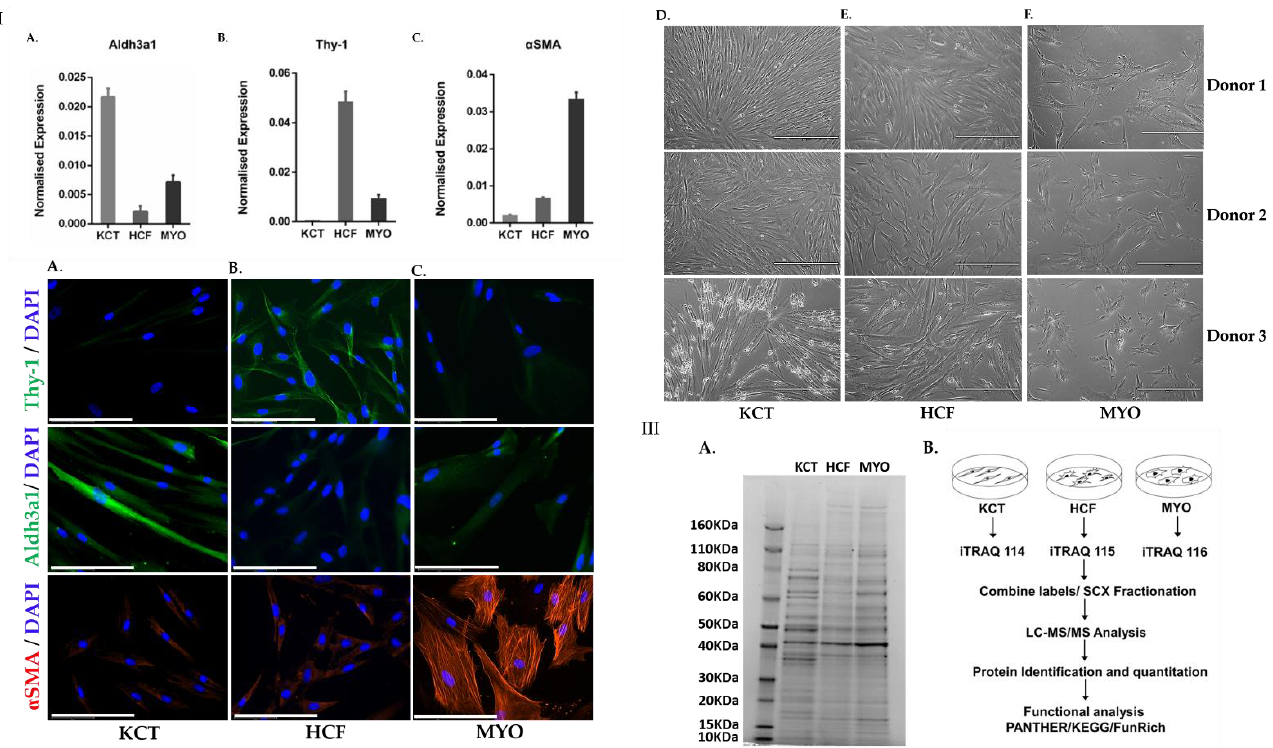
Figure 1. Corneal stromal cell differentiation and cell-specific gene expression markers. ( I ) (A) Aldh3a1 gene specific for keratocytes was observed to have higher expression in KCT, confirming the phenotype. (B) Genetic marker Thy-1 for fibroblasts showed higher expression levels in HCF compared to keratocytes and myofibroblasts. (C ) Expression of α -SMA, a characteristic marker for myofibroblasts, was observed to be higher in myofibroblasts, validating the morphological changes. Data represent results from three technical replicates. (D) Corneal keratocytes (KCT) with a distinct dendritic morphology upon culture in serum-free DMEM – F12 medium (96 h) as shown in three donors. (E) Corneal fibroblasts (HCF) showing proliferation and confluency (36 h) in DMEM-F12 with 10% FBS as shown in all four donors. (F) Corneal myofibroblast (MYO) differentiated from HCF (120 h) upon treatment with TGF- β (1 ng/mL) as shown in all four donors. Scale bar: 100 µm. ( II ) Immunocytochemistry of primary keratocytes, fibroblasts and myofibroblasts. (A) Thy-1, Aldh3A1 and alpha SMA expression as shown in keratocytes (KCT). (B) Thy-1, Aldh3A1 and alpha SMA expression as shown in Human Corneal Fibroblasts (HCF). (C) Thy-1, Aldh3A1 and alpha SMA expression as shown in Corneal myofibroblast (MYO). In the top lane, Thy 1 expression (green fluorescence) was higher in fibroblasts as compared to keratocytes and myofibroblasts. In the middle lane, Aldh3A1 marker (green fluorescence) was expressed higher in keratocytes as compared to fibroblasts and myofibroblasts. In the bottom lane, the expression of alpha SMA marker (red fluorescence) expression was higher in myofibroblasts.